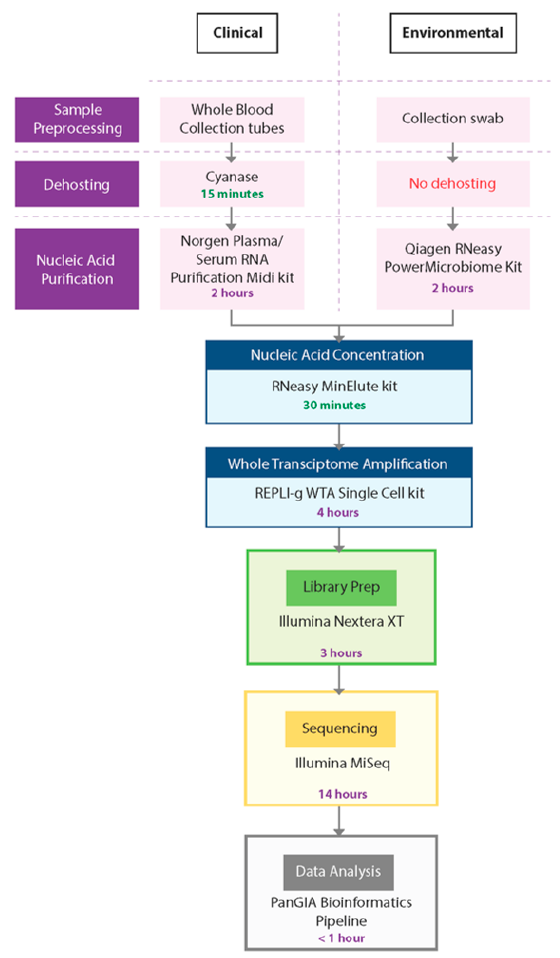
Figure 2. PanGIA Clinical and Environmental Workflows. This figure provides an illustration of the PanGIA Clinical and Environmental Workflows. The workflows share similar steps following Nucleic Acid